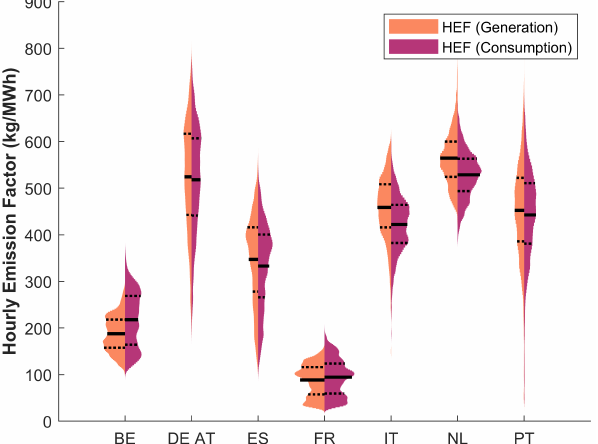
Figure 2. Violin plot of distribution Generation and Consumption Hourly Emission Factors per bidding zone. Solid line indicates mean, dashed lines the 25% and 75% percentiles. Country codes: BE = Belgium, DE = Germany, AT = Austria, ES = Spain, FR = France, IT = Italy, NL = Netherlands, PT =